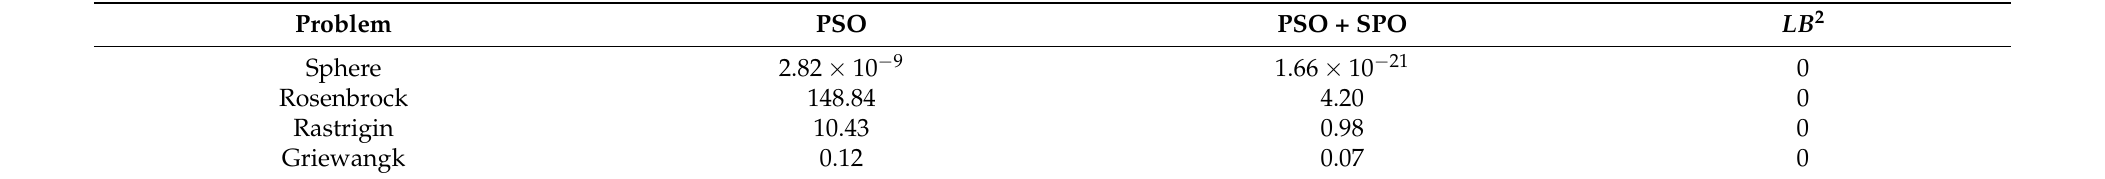
Table 9. Comparison results of SPO against LB 2